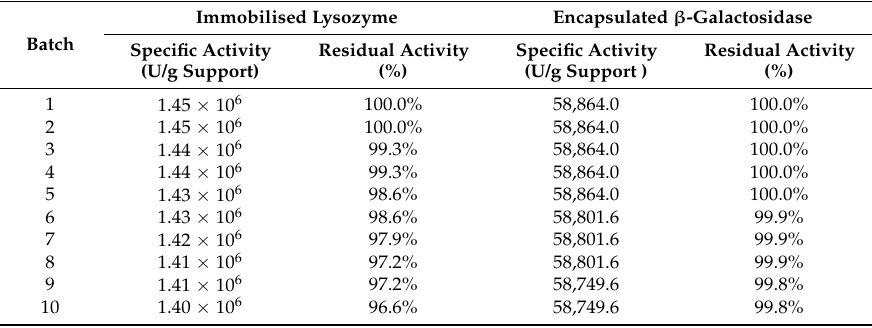
Table 2. Antimicrobial activity and lactose hydrolytic activity of the co-immobilised enzymes during continuous